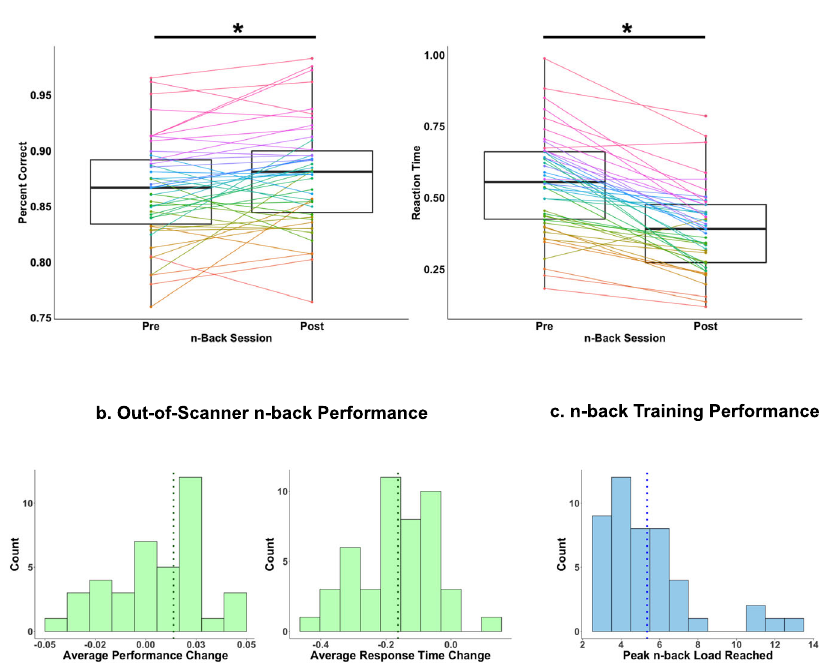
Fig. 2 Individual differences in learning gains. a Individual differences in out-of-scanner n -back accuracy and response time (averaged across conditions) changes. Each colored line represents an individual participant. b Task performance on the out-of-scanner pre- and post-training n - back task, measured by accuracy (or percentage of correct trials), averaged across task conditions (left panel) and response time (in seconds) averaged across tasks conditions (right panel). Vertical dashed lines represent mean values. c Highest n -back condition achieved during training.